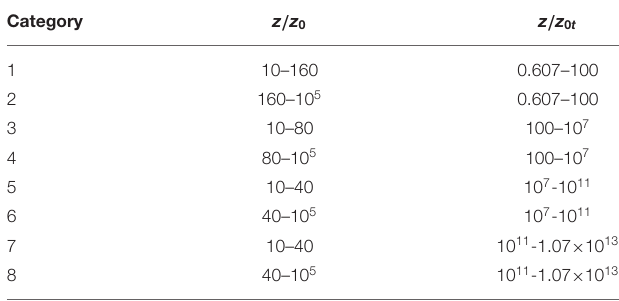
TABLE 1 | The eight categories divided according to the values of z / z 0 and z / z 0 t